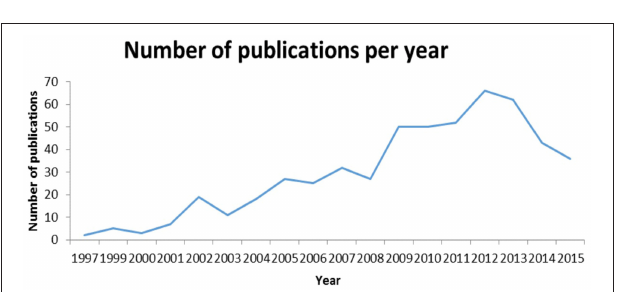
FIGURE 1 | Sample antibiotic resistance data from the city of Yakutsk (Russia). The chart shows resistance of Pseudomonas aeruginosa to Gentamicin.